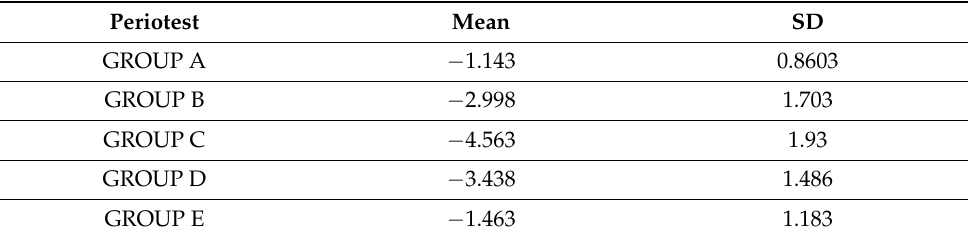
Table 3. Periotest means of the study groups.